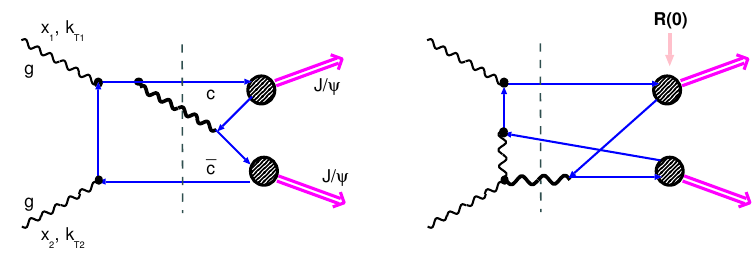
Figure 2. Two sample diagrams for the SPS mechanism of J /ψ -pair production in the color-singlet model. In the k T -factorization approach incoming gluons carry longitudinal momentum fractions x 1 , 2 and transverse momenta (cid:126) k T 1 , (cid:126) k T 2 .